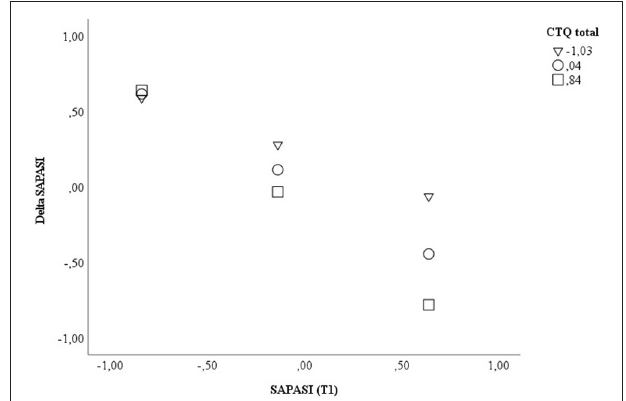
FIGURE 2 | Displayed are the data for visualizing the conditional effect of the predictor SAPASI at T1 on Delta SAPASI, depending on the severity of the CTQ total at T1. Z-standardized values were used. CTQ, Childhood Trauma Questionnaire; SAPASI, Self-administered Psoriasis Area and Severity Index.